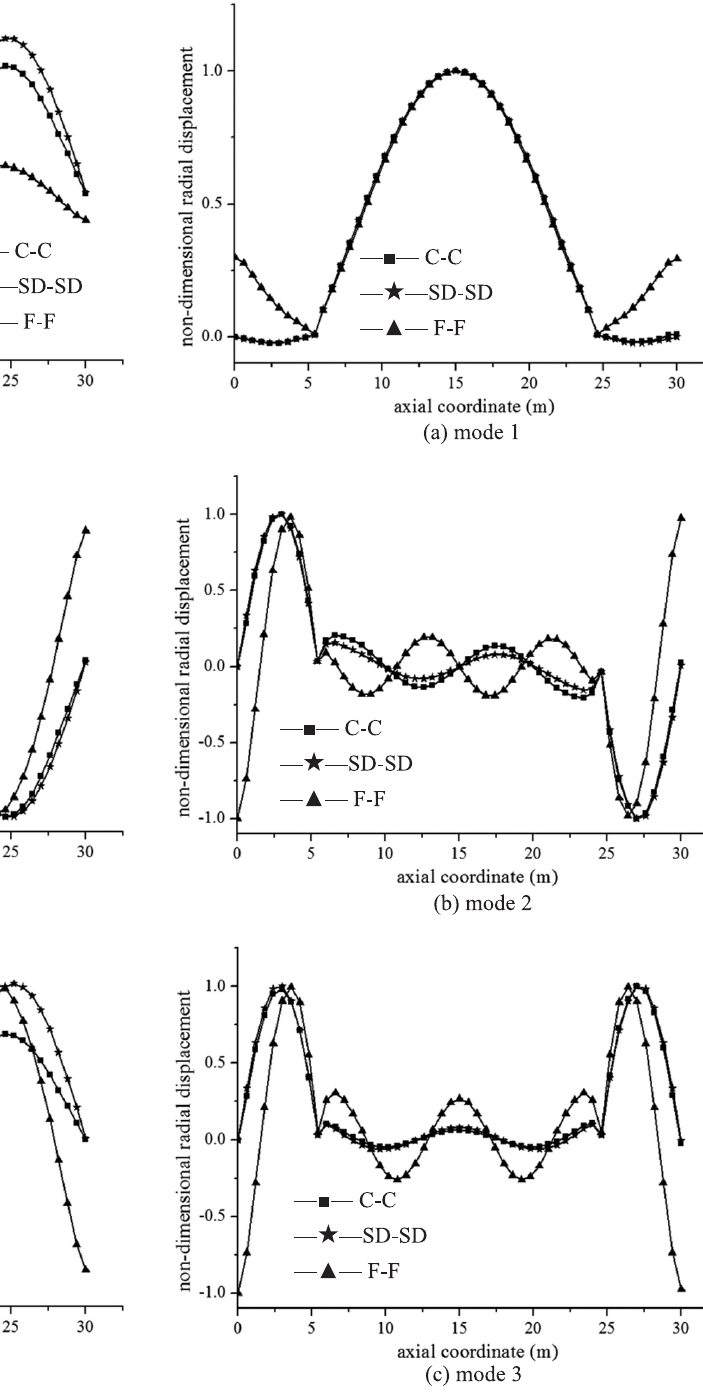
Fig. 16. Vibration mode shapes of model M4 when n = 4 with dif- ferent boundary conditions.